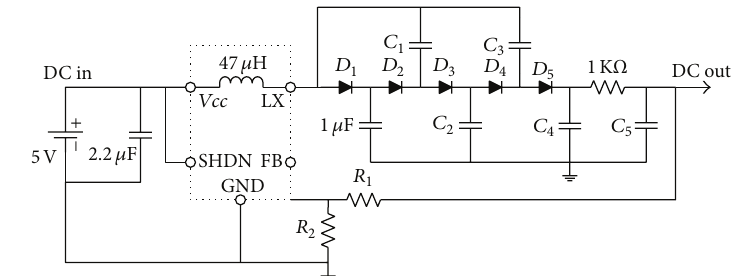
Figure 11: DC-DC converter circuit for the RF-MEMS switch.